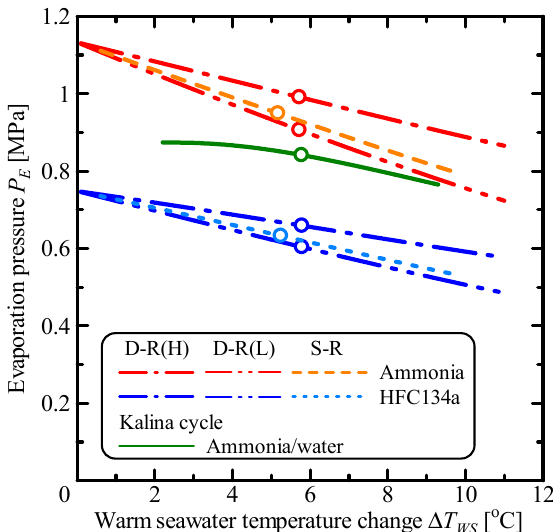
Figure 12. Relationship between the evaporation pressure and the warm seawater temperature change.